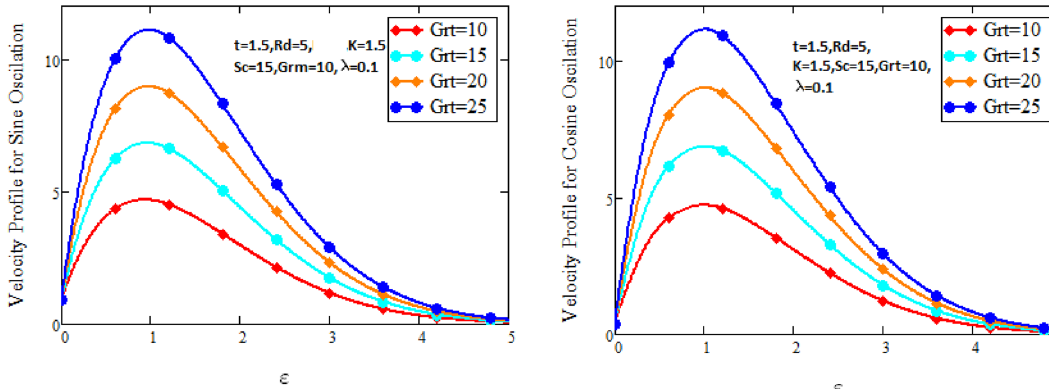
Figure 3. Velocity curves for various values of Gr t .